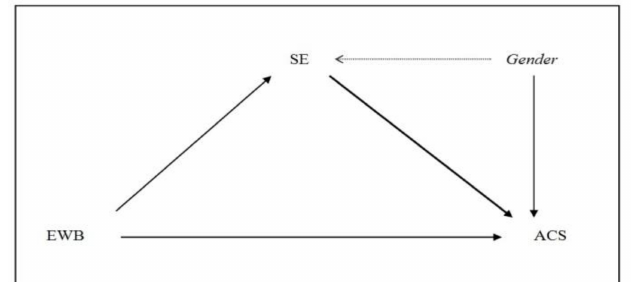
Figure 1. Mediational model. EWB = Eudaimonic Well-Being; SE = Self-Efficacy; ACS = Adaptive Coping